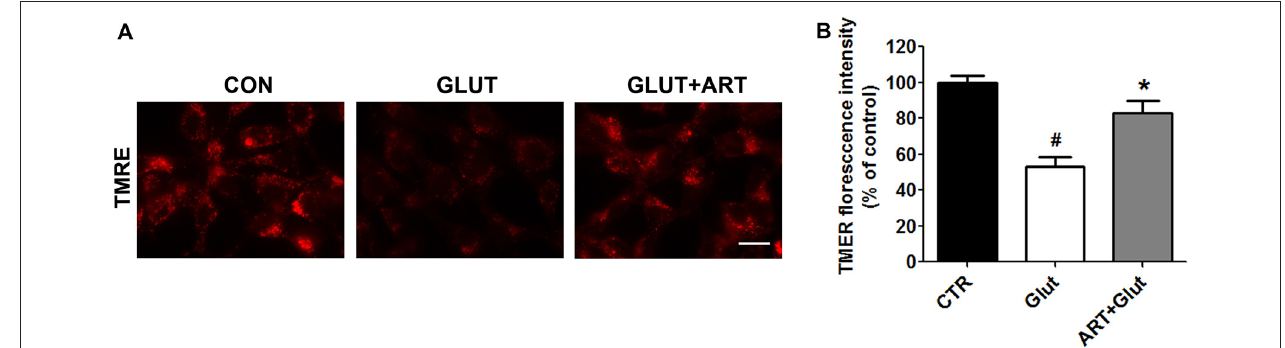
FIGURE 4 | Artemisinin attenuated the glutamate-induced collapse of mitochondrial membrane potential. (A) Tetramethylrhodamine, Ethyl Ester (TMRE) staining showed that artemisinin could reduce glutamate-induced ∆ψ m loss. (B) Quantitative data of (A) . Scale bar = 20 µ m. # p < 0.05 vs. CON group, ∗ p < 0.05 vs. GLUT group.